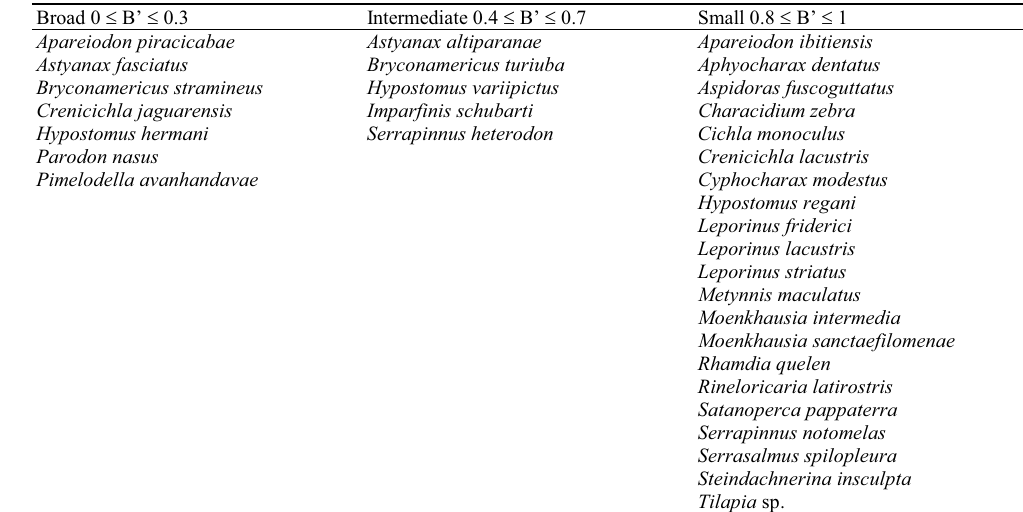
Table 3. Niche Breadth (B’) for Habitat Use of the Fishes Registered in the Ribeirão Santa Bárbara